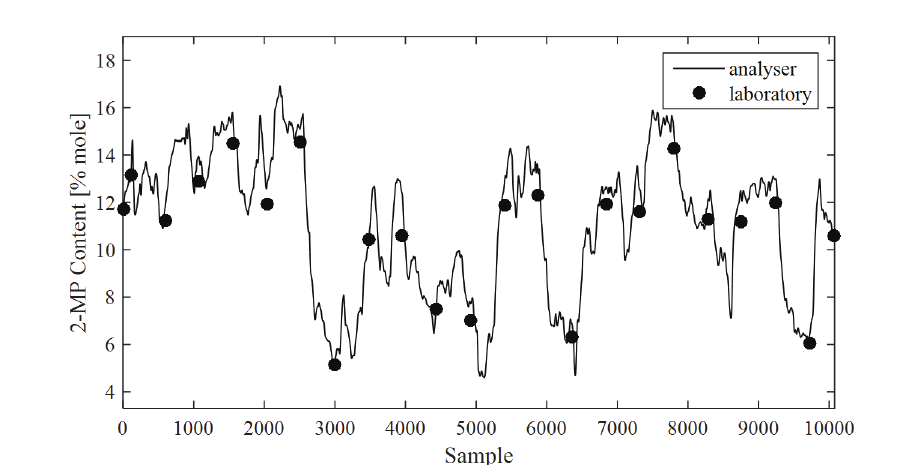
Fig. 9 – Comparison between 2-MP content output variable measured by the on-line chromatographic analyser and the laboratory analysis within 2016 data period